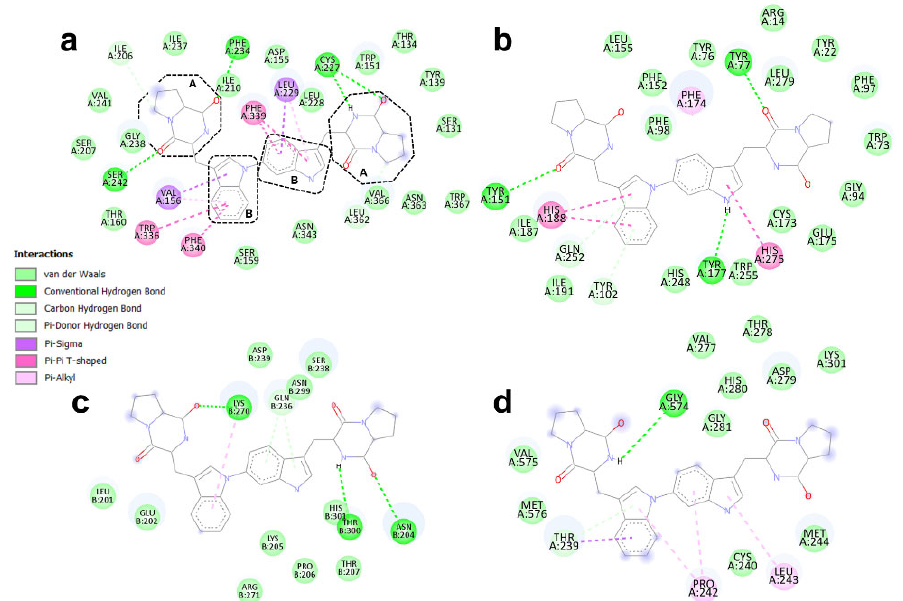
Figure 9. Receptor–ligand interactions of aspergilazine A ( A1 ). The interactions between aspergilazine A and the residues involved in the binding sites for ( a ) 5 ‐ HT 2A ; ( b ) PAF ‐ R; ( c ) IL ‐ 1R1; ( d ) EGF ‐ R are depicted. In (a), the aspergilazine A substructures are indicated as follows: A and D represent the pyrrole [1,2 ‐ a] pyrazin ‐ 4 ‐ one moiety; B and C represent the indole moiety. The color legend indicates the type of interaction. Green color represents H ‐ bond ‐ type interactions, and the pink − purple color is used for hydrophobic interactions.